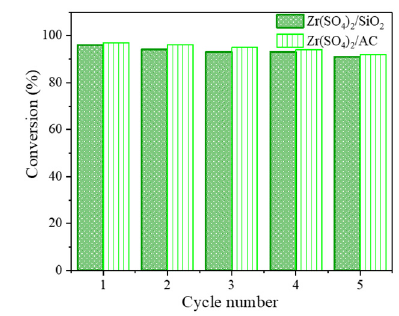
Figure 7. Recyclability of Zr(SO 4 ) 2 / SiO 2 and Zr(SO 4 ) 2 / AC catalysts. Reaction conditions: Methanol (5 mL), malic acid (1 g), catalyst amount (0.1 g), reaction time (2 h), reflux temperature, stirring speed (600 rpm).